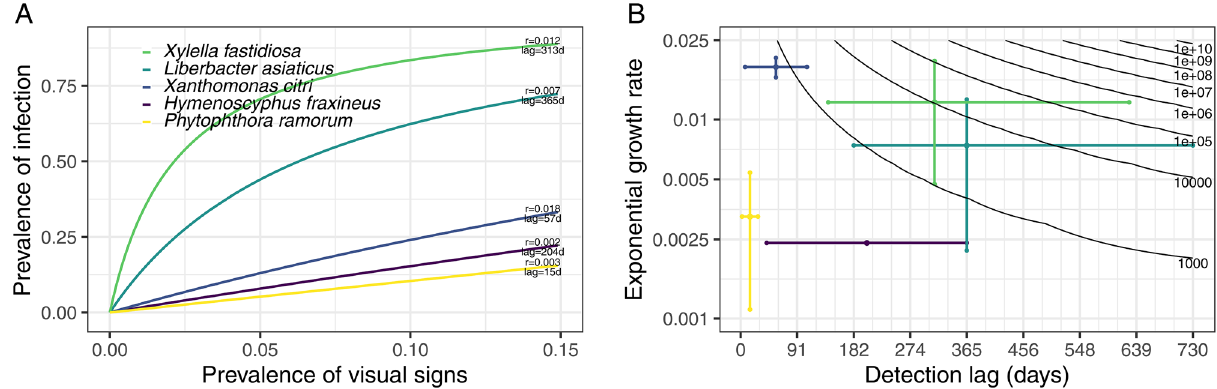
Figure 4. The asymptomatic period for Xylella fastidiosa makes it very difficult to detect at an early stage when using visual inspection. ( A ) The highest difference between apparent and true prevalence is seen for olive quick decline syndrome, caused by X. fastidiosa . This plot shows the relationship between the apparent prevalence (on the x-axis) and the true prevalence (on the y-axis) for a number of different pathogens (associated disease): Hymenoscyphus fraxineus (ash dieback); Xanthomonas citri subsp. citri (citrus canker); Candidatus Liberbacter asiaticus (huanglongbing); X. fastidiosa ST53 (olive quick decline syndrome); Phytophthora ramorum (ramorum). ( B ) In order to confidently declare pest freedom, more samples are needed when the asymptomatic period and/or the spread rate are high. This plot shows the relationship between the detection lag (x-axis), the exponential growth rate (on a logarithmic scale on the y-axis), and the number of samples (also on a logarithmic scale, in the contour lines) required to be 90% confident that the true prevalence is lower than 1% given that no positive detections are made. The coloured lines indicate our best estimates of the growth rate and presymptomatic period for the pathogens considered 10